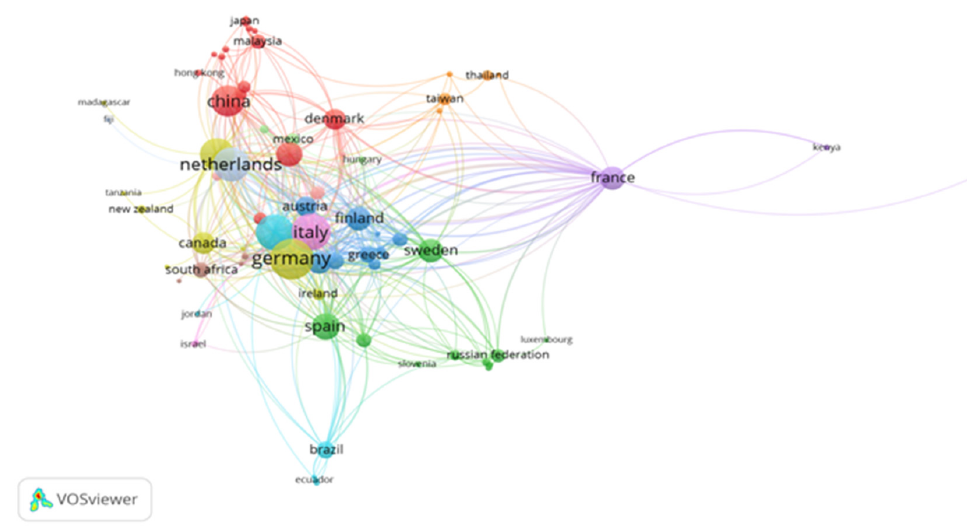
Figure 4. Co-authorship analysis/countries .